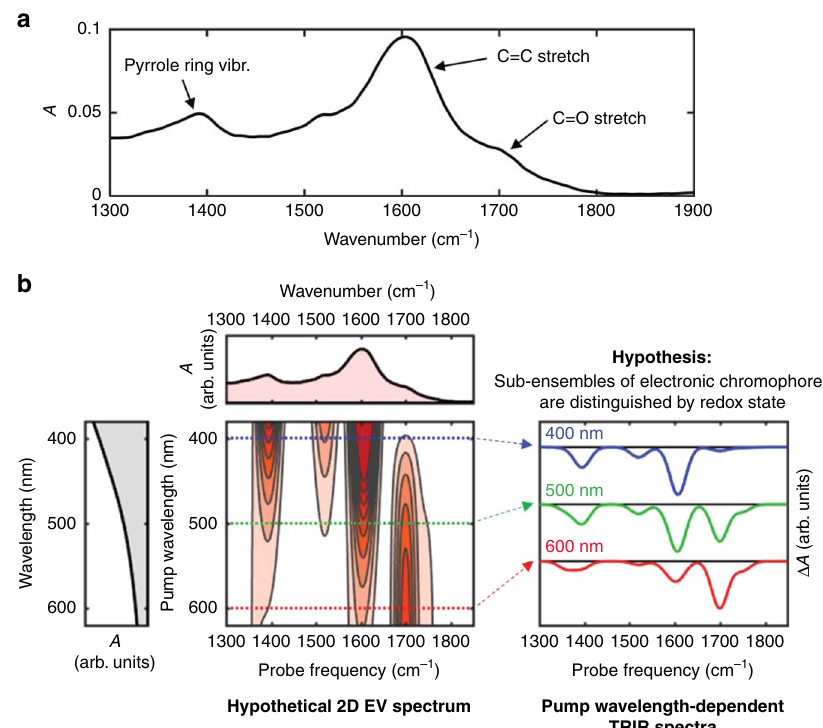
Fig. 3 Vibrational spectroscopy of DOPA melanin and UVF predictions. a FTIR spectrum of DOPA melanin dissolved in phosphate-buffered D 2 O, including vibrational assignments. b Ultrafast vibrational fi ngerprinting (UVF) spectroscopy vs. two-dimensional electronic-vibrational (2D EV) spectroscopy for a hypothetical sample containing multiple electronic chromophores that can be distinguished by the redox state of their oxidizable IR- active functional groups. With time-resolved infrared (TRIR) spectroscopy (right), a subensemble of eumelanin chromophores is photoselected using a particular visible wavelength and its time-resolved vibrational spectrum is measured. These spectra are essentially horizontal slices through the hypothetical 2D EV spectrum (left). The 2D signals are assumed to only contain negative absorptive (bleaching) contributions for simplicity. Note that the presence of positive signal contributions from new vibrational frequencies in excited electronic states can alter the positions of the negative